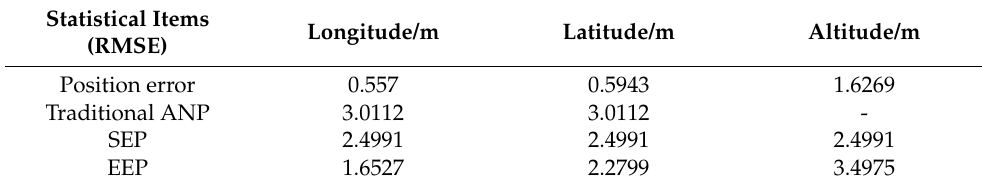
Figure 15. Comparison between altitude position error and ANP. shown in Table 3. Table 3. Comparison of actual navigation performance evaluation algorithm results.